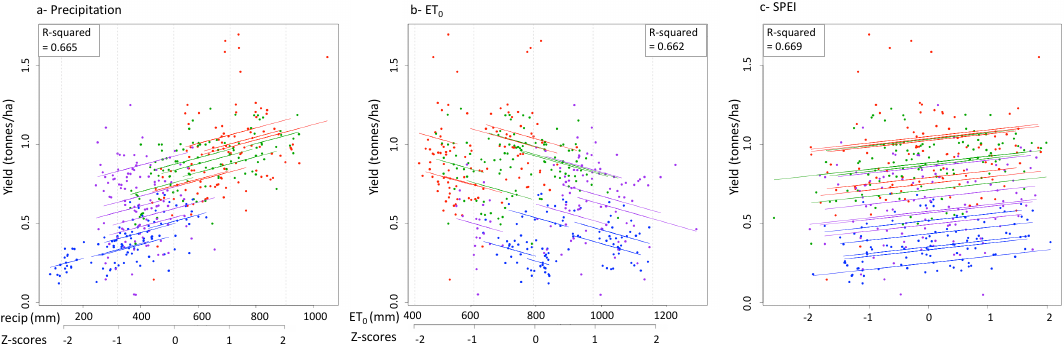
Figure 8. Using yield data, precipitation, ET 0 , and SPEI for 1996–2016, ( a ) this image shows the regression of precipitation predicting yield. ( b ) this image shows the regression of ET 0 predicting yield. ( c ) this image shows the regression of SPEI predicting yield. The data are identified by country in different colors: Burkina Faso represented in red, Mali in green, Niger in blue, and Senegal in purple. There were five regions per country, which are further represented by different regression lines in the plots—all plotted with corresponding colors to the country they are in. Further information on specifications of the regression models can be found in Table